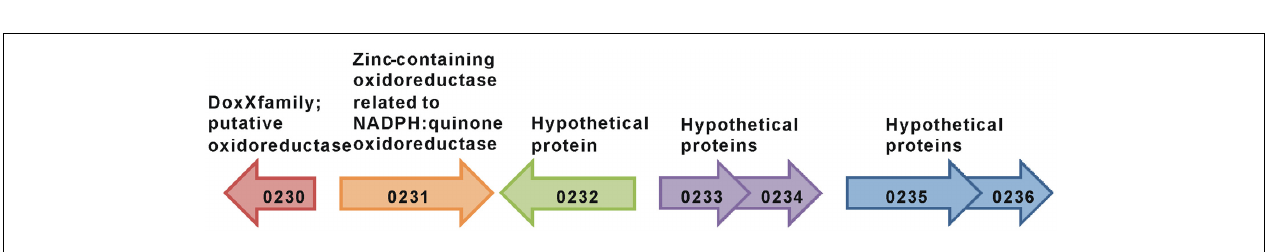
FIGURE 3 | The Gmet 0232 genomic